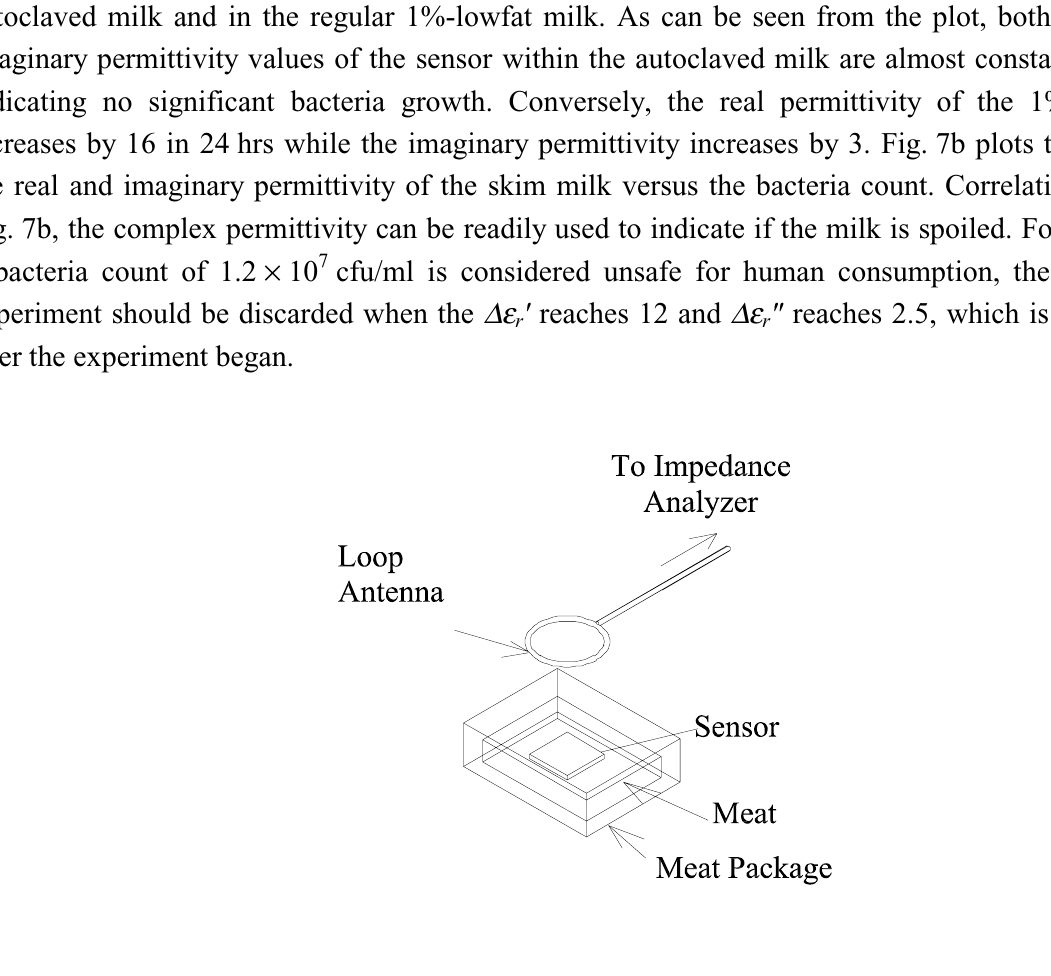
Figure 8. The experimental setup for meat quality monitoring. The sensor is placed between the meat and the wall of the Styrofoam package container.